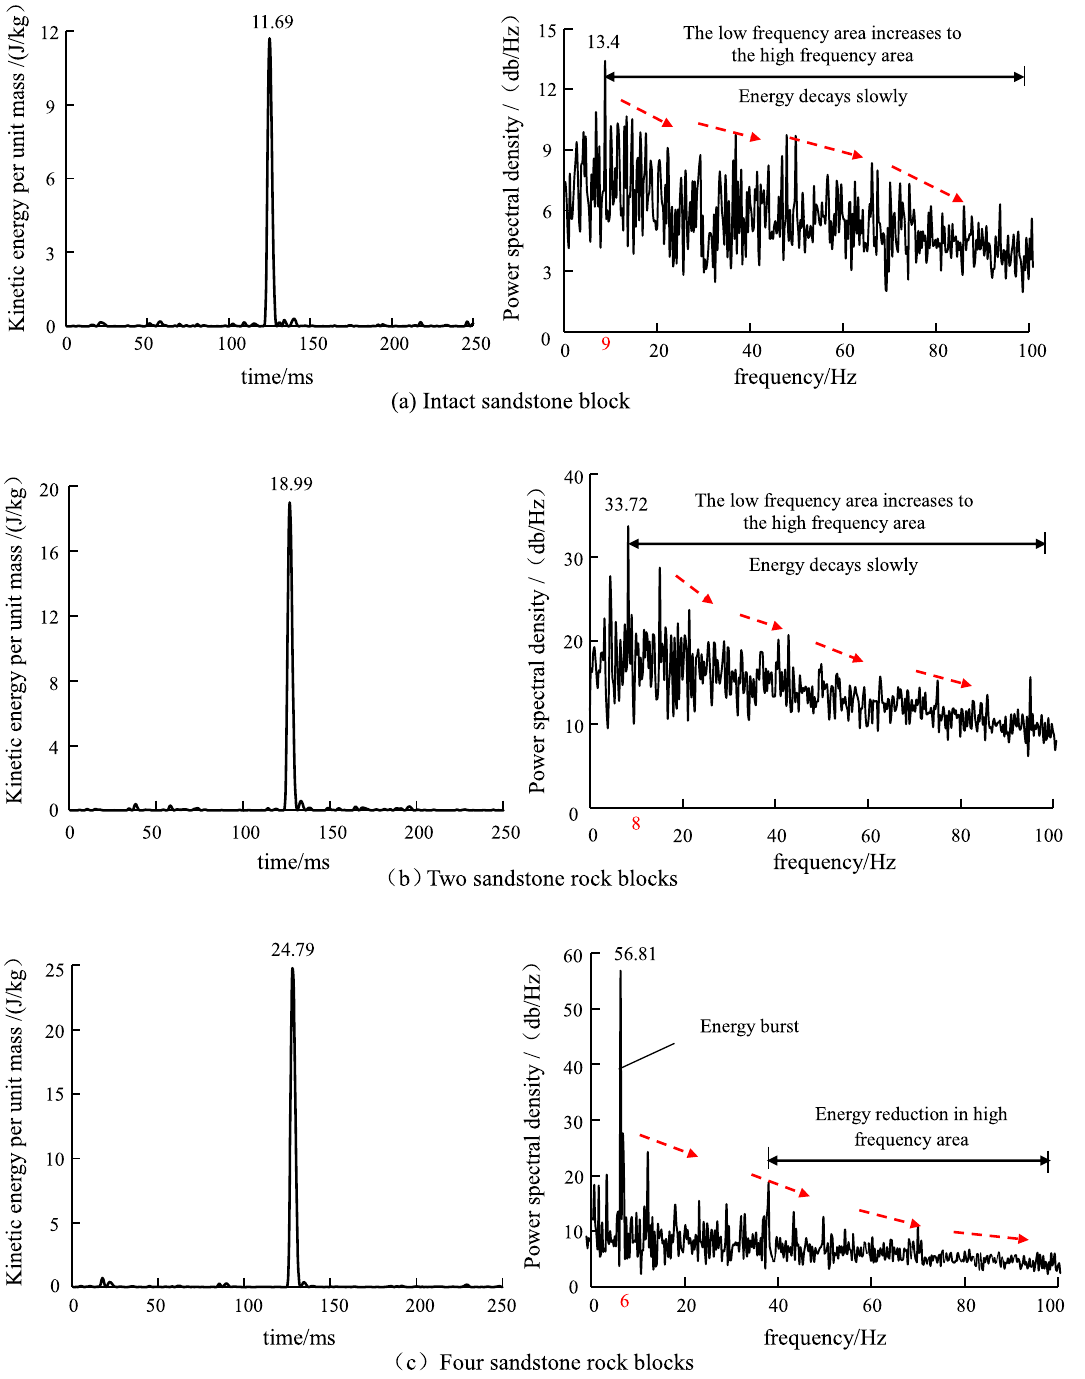
Fig. 12 Kinetic energy per unit mass and curves of power spectral density of different degrees of fracture under a horizontal impact of 2.5